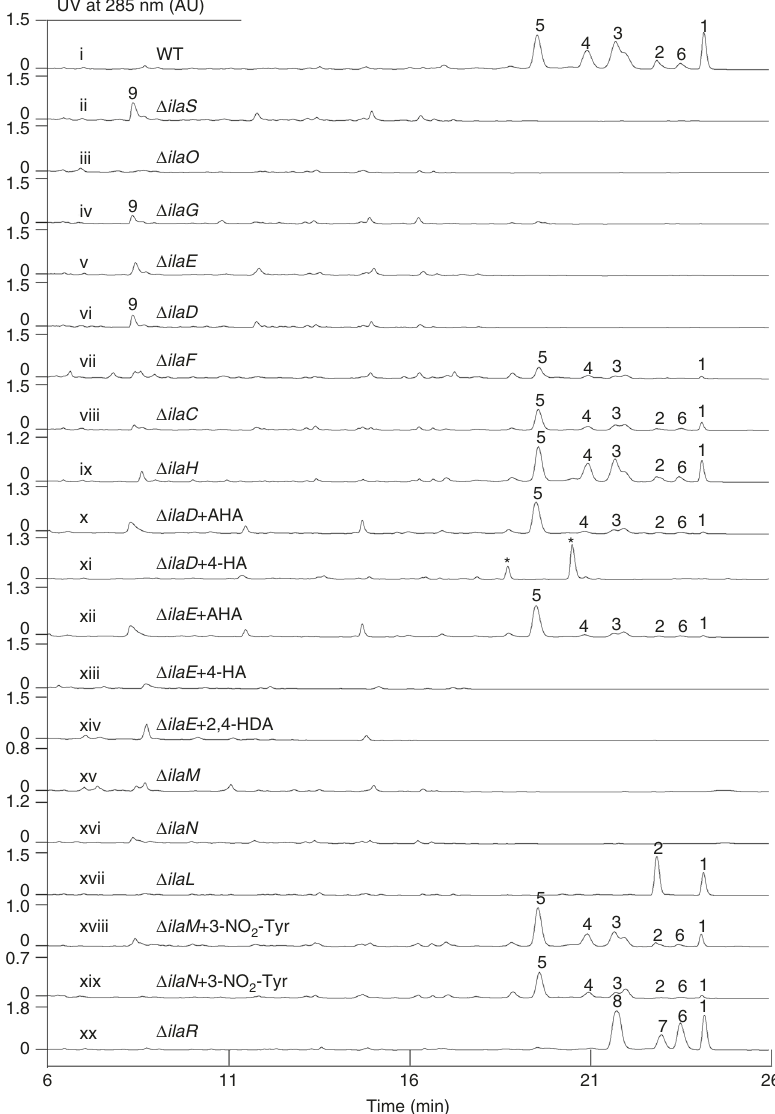
Fig. 2 HPLC analyses of fermentation broths. (i) wild-type S . atratus SCSIO ZH16; (ii) Δ ilaS mutant; (iii) Δ ilaO mutant; (iv) Δ ilaG mutant; (v) Δ ilaE mutant; (vi) Δ ilaD mutant n; (vii) Δ ilaF mutant; (viii) Δ ilaC mutant; (ix) Δ ilaH mutant; (x) Δ ilaD mutant fed with AHA; (xi) Δ ilaD mutant fed with 4-HA; (xii) Δ ilaE mutant fed with AHA; (xiii) Δ ilaE mutant fed with 4-HA; (xiv) Δ ilaE mutant fed with 2,4-HDA; (xv) Δ ilaM mutant; (xvi) Δ ilaN mutant; (xvii) Δ ilaL mutant; (xviii) Δ ilaM mutant fed with 3-NO 2 -tyr; (xix) Δ ilaN mutant fed with 3-NO 2 -tyr; (xx) Δ ilaR mutant; the peaks labeled with asterisks are not ilamycin analogs judged by HPLC – DAD – UV residues in these heptapeptides 10 , determined the S con fi gura- which is also present in ilamycin B 1 ( 1 ). Comparison of the 1 H tions for C 13 and C 32 in 2 and 5 . Minor product 6 was puri fi ed as a yellow powder. The molecular formula of 6 was established by high resolution electrospray ionization massspectroscopy (HRESIMS) to be E 1 .